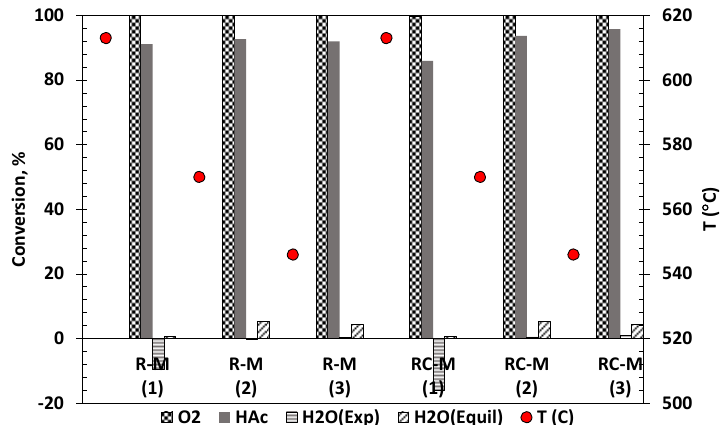
Figure 7. Temperature (in °C, right ordinate) and conversions of HAc, O 2 , and H 2 O (exp. and equil., left ordinate) using R-M and RC-M monoliths for ATR with water flow set at S/C molar ratio of 1, 2, 3 and pressure of 1 bar. S/C is given in parentheses below the catalyst name.